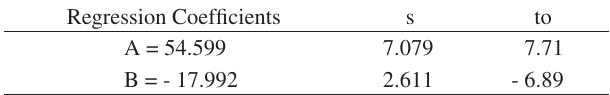
Table 3. Regression coefficients of Equation 7 with their respective standard deviations s and to ratios.